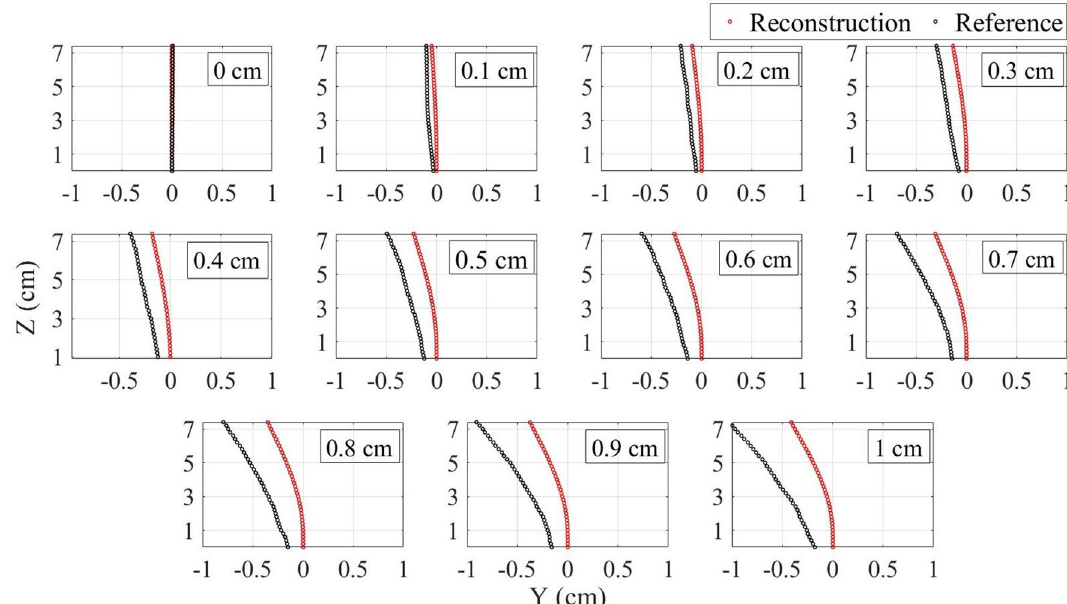
Figure 2. Comparison of the reconstructed shape (red) with the reference (black) before the application of the correction coefficients during the needle bending to the lower direction.